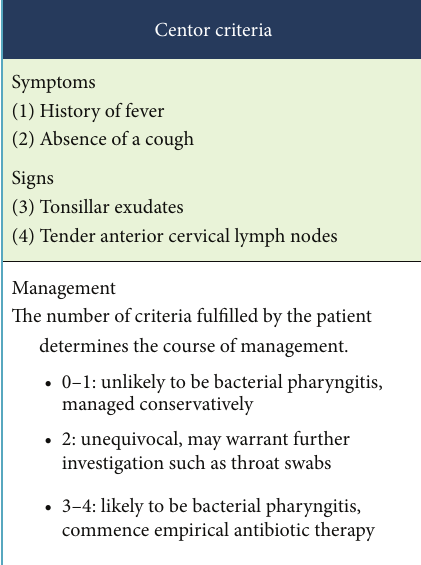
Figure 1: Centor